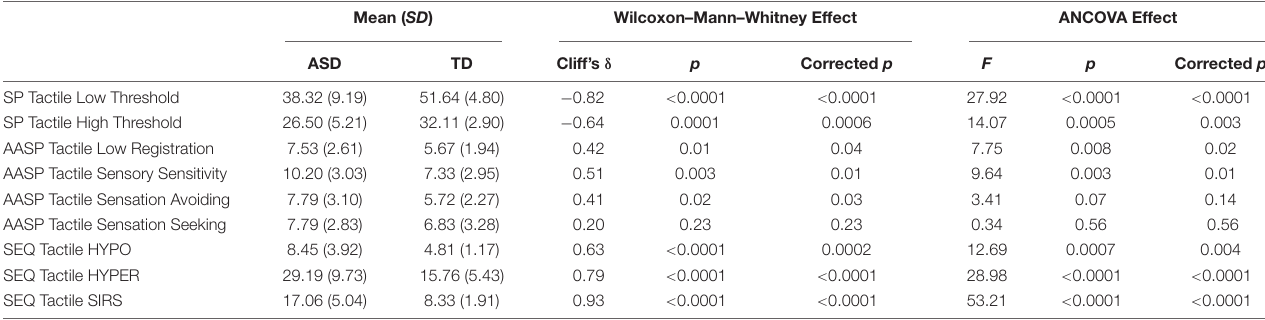
TABLE 4 | Results of statistical comparisons of autistic and typically developing groups on Sensory Profile (SP), Adolescent-Adult Sensory Profile (AASP), and Sensory Experiences Questionnaire (SEQ) scores in the tactile